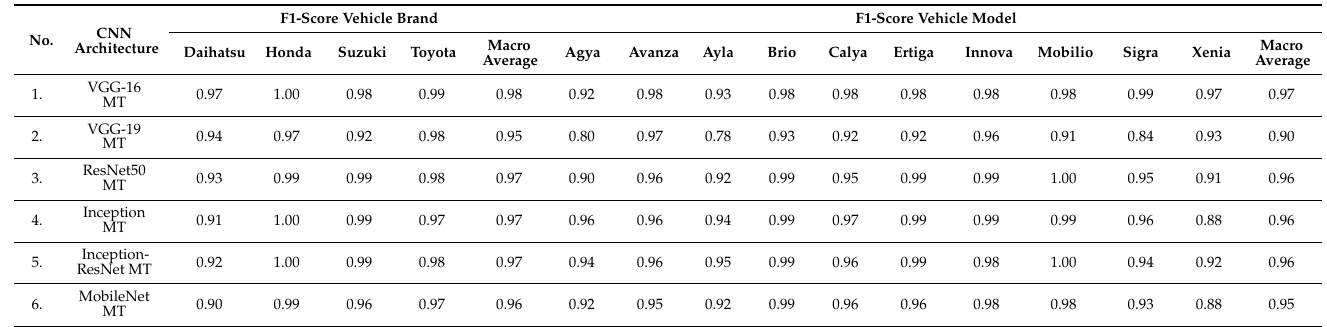
Table 8. The F1-Score results for vehicle brand and vehicle model recognition using the proposed